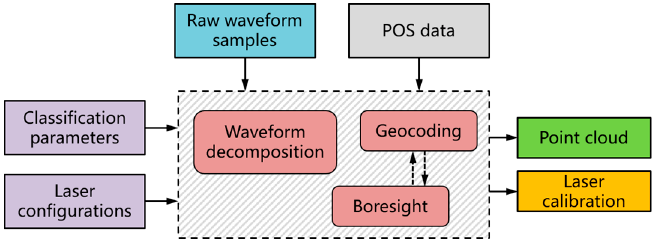
Figure 5. The workflow of waveform LiDAR data processing.